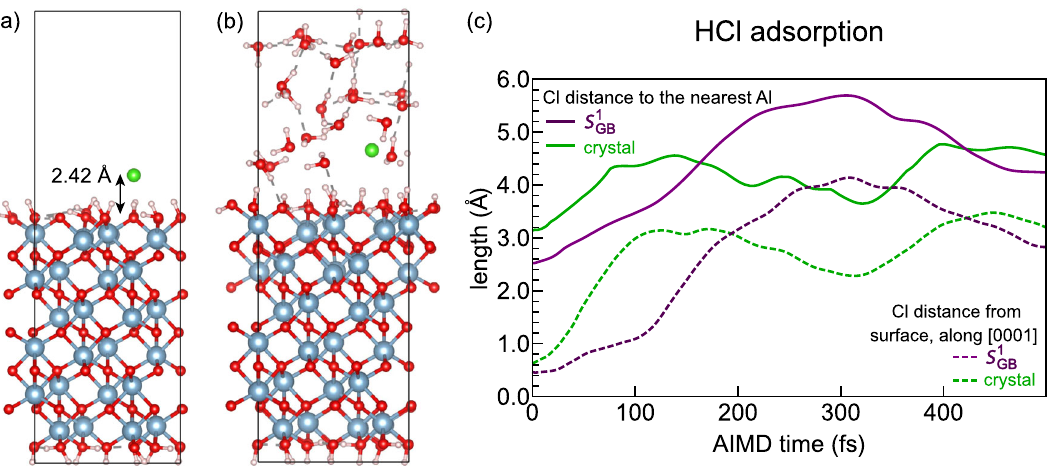
Fig. 4 Adsorption of a dissociated HCl molecule on single-crystal (0001) surface. Cl is represented by the green atom. a The supercell con fi guration after zero-K DFT minimization, where Cl is 2.42 Å away (along [0001]) from the surface de fi ned as the top layer of O atoms. b The supercell con fi guration after 500 fs AIMD at 300 K. c The distance of Cl from the surface along [0001] (dashed lines) and the distance of Cl to the nearest Al atom (solid lines) for the single-crystal surface (green) and the surface with GB terminations (purple). Other simulations with different initial positions of water molecules and Cl also resulted in similar desorption processes of